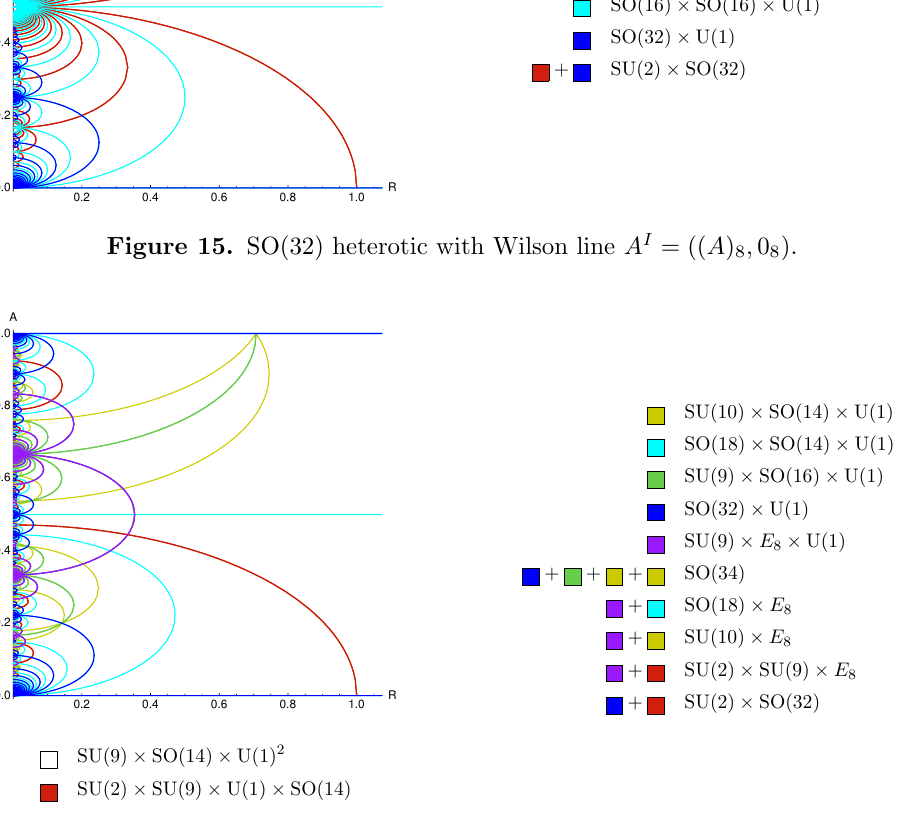
Figure 16. SO(32) heterotic with Wilson line A I = (( A ) 9 ; 0 7 ).